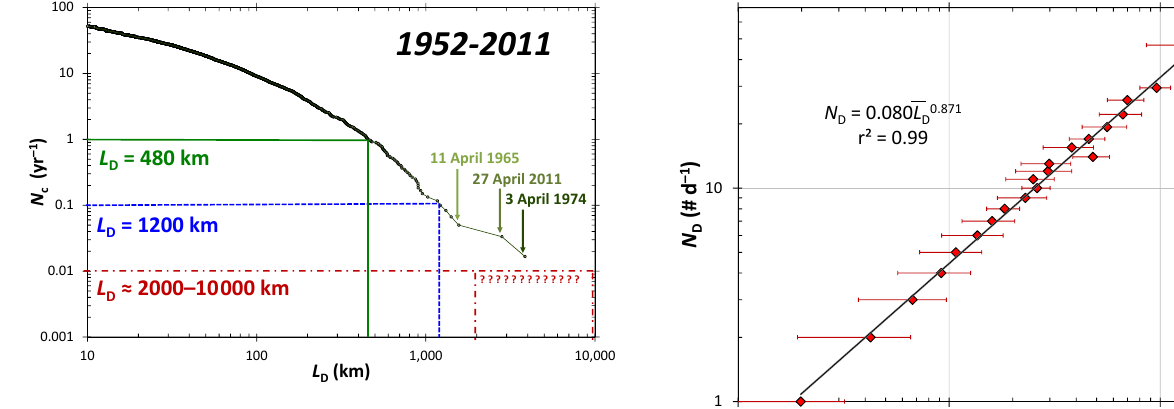
Fig. 13. Cumulative number of continental USA severe tornado out- breaks per year N c with daily total path lengths greater than or equal to L D , given as a function of L D . The data are for the period 1952– 2011 with outbreak total path lengths L D based only on tornadoes with path lengths L ≥ 10km (defined in this paper to be severe tor- nadoes). The three longest outbreaks are identified by vertical ar- rows. Using this data, rough estimates are made for the length of the expected 1-yr, 10-yr, and 100-yr outbreaks. Tornado path length data L are from NOAA (2012).